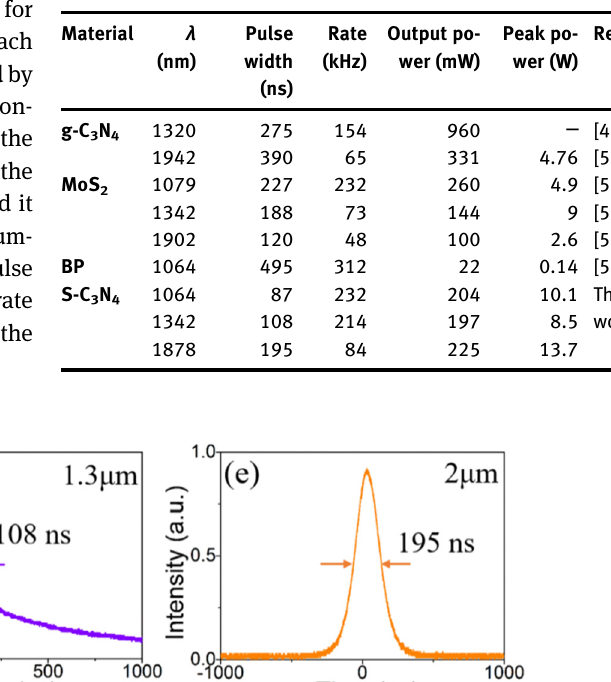
Table  : The laser output performance comparison of S-C  N  with different SAs at  ,  .  , and  μ